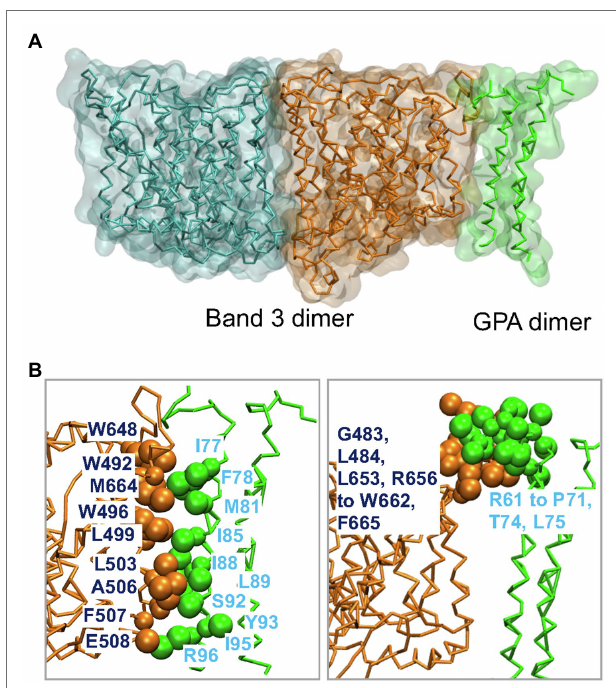
FIGURE 4 | (A) Molecular dynamics (MD) simulation model of the interaction of the dimeric membrane domain of Band 3 shown in orange and cyan and the TM portion of the Glycophorin A (GPA) dimer shown in green. This snapshot is taken from one of the simulations in Kalli and Reithmeier (2018). (B) Contacts between Band 3 (orange) and Glycophorin A (green). Main residues in the interface between the TM segments of Band 3 and Glycophorin A are shown in VdW representation. See Kalli and Reithmeier (2018) for more